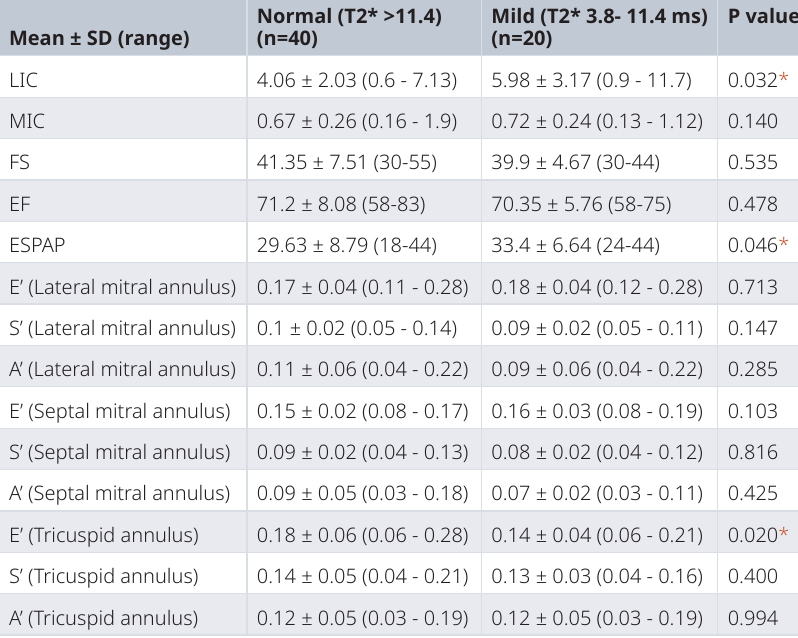
Table 3. Comparison of hepatic and cardiac iron and cardiac functions in relation to pancreatic